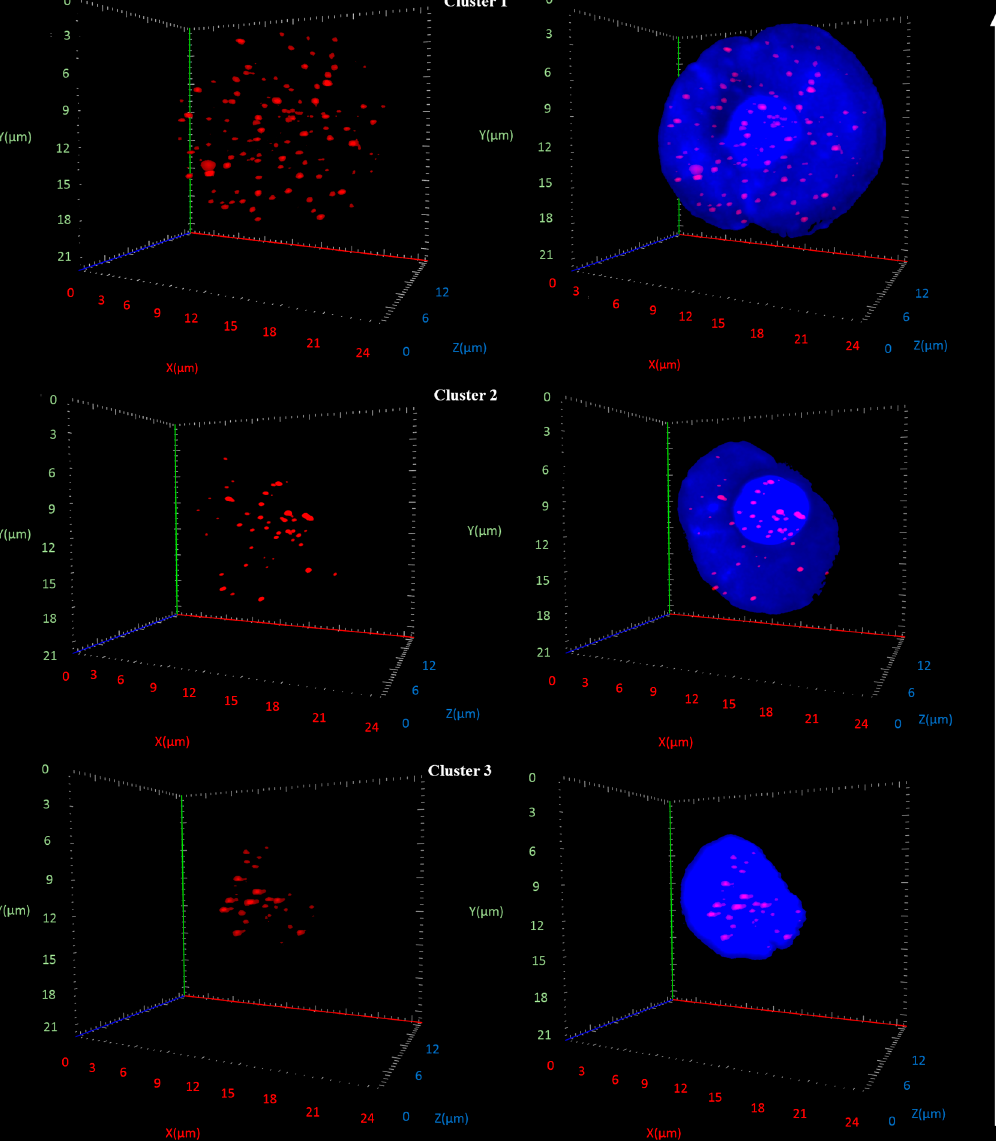
Figure 2. Representative images of CTCs from patients in cluster 1, 2 and 3. Left panels: 3D telomere (red) images. Right panels: 3D telomeres (red) in CTC nuclei (blue). Note the micrometer ( μ ) scales for nuclear sizes as shown for each 3D image in the x, y, z positions of the image. A white arrow indicates the increase in the level of genomic instability from cluster 3 to 2 to 1 (for details, see text).